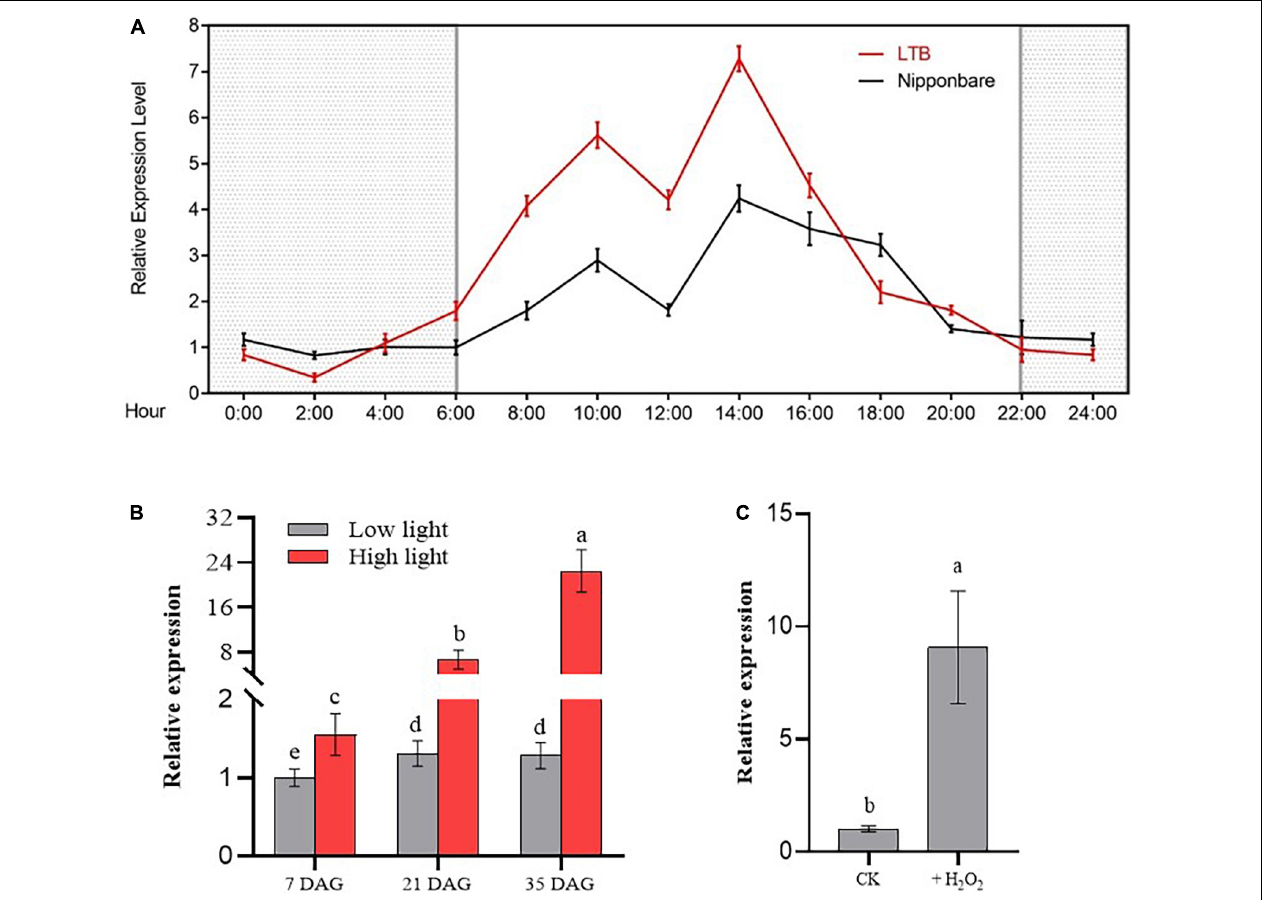
FIGURE 1 | Relative expression of OsGUN4 in seedlings 35 days after germination. (A) Variation of OsGUN4 expression in wild-type indica rice Longtepu B (LTB) and japonica rice Nipponbare across a 24-h period grown in growth room in photoperiodic conditions (16 h light/8 h dark). The light intensity was 1000 µ mol m − 2 s − 1 and the temperature was set at a constant 30 ◦ C. Samples were taken every 2 h from 6:00 am when light was turned on. Relative expression is reported relative to that of Nipponbare at 6:00 am, which was assigned a value of 1. (B) Relative expression of OsGUN4 in LTB seedlings at 35 days